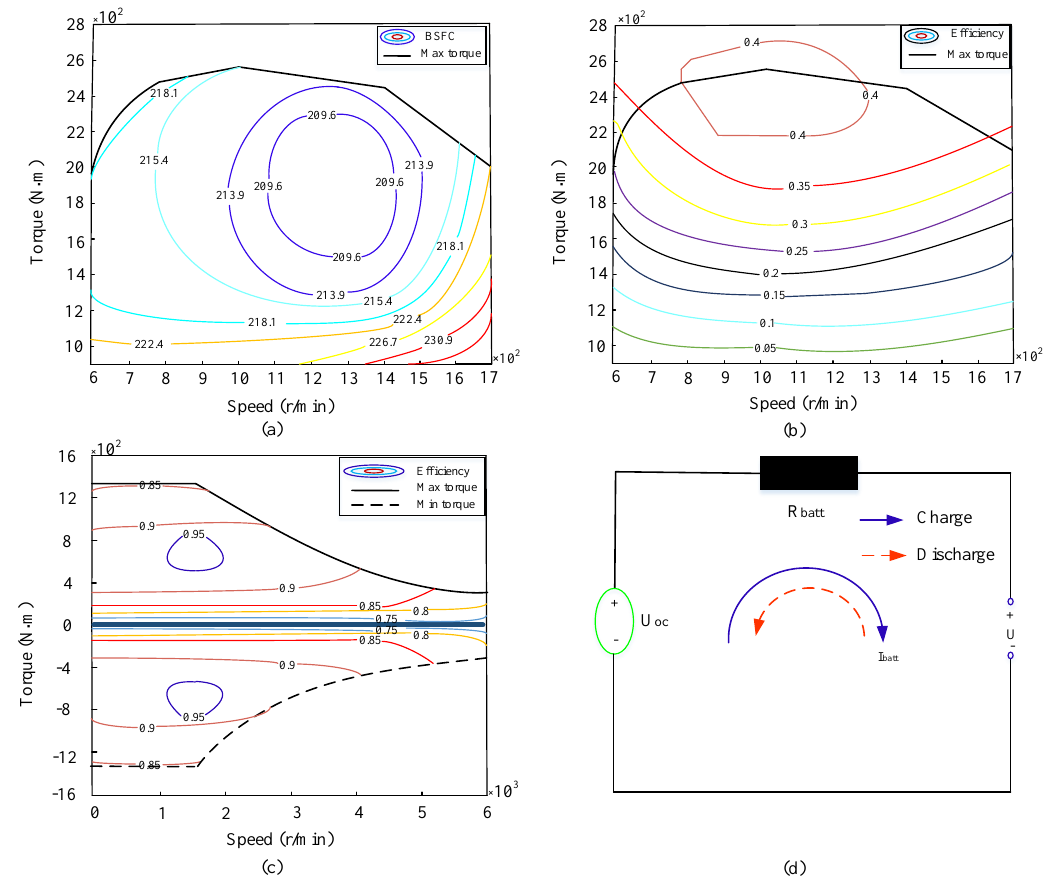
Figure 2. ( a ) MAP of the engine. ( b ) Efficiency MAP of the engine. ( c ) Efficiency MAP of the motor. ( d ) Battery equivalent circuit diagram.